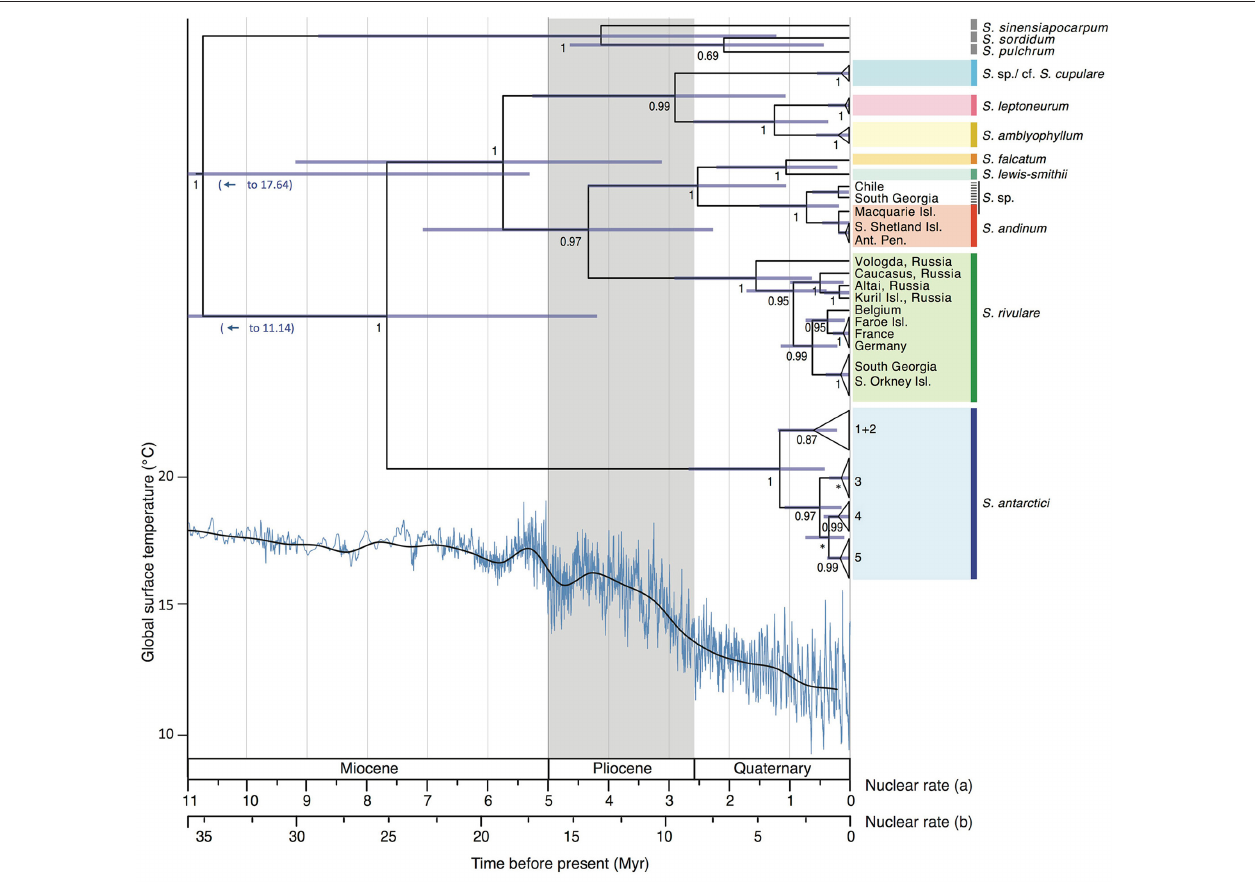
FIGURE 5 | Maximum clade credibility tree presenting median divergence time estimates between and within different Antarctic Schistidium species as estimated from ITS sequences. Information on global surface temperature estimates reproduced from Hansen et al. (2013) is provided below (blue lines represent global surface temperature variations, and the black line represents a 500 kyr smoothed resolution). Timescales for different rates are shown and are based on previously calculated nuclear substitution rate in (a) Polytrichaceae mosses, and (b) in angiosperms (see Methods). The phylogeny and global surface temperature are based on rate (a). Posterior probability (PP) is shown below nodes, with PP < 0.5 indicated as *. Node bars represent age estimate 95% height posterior